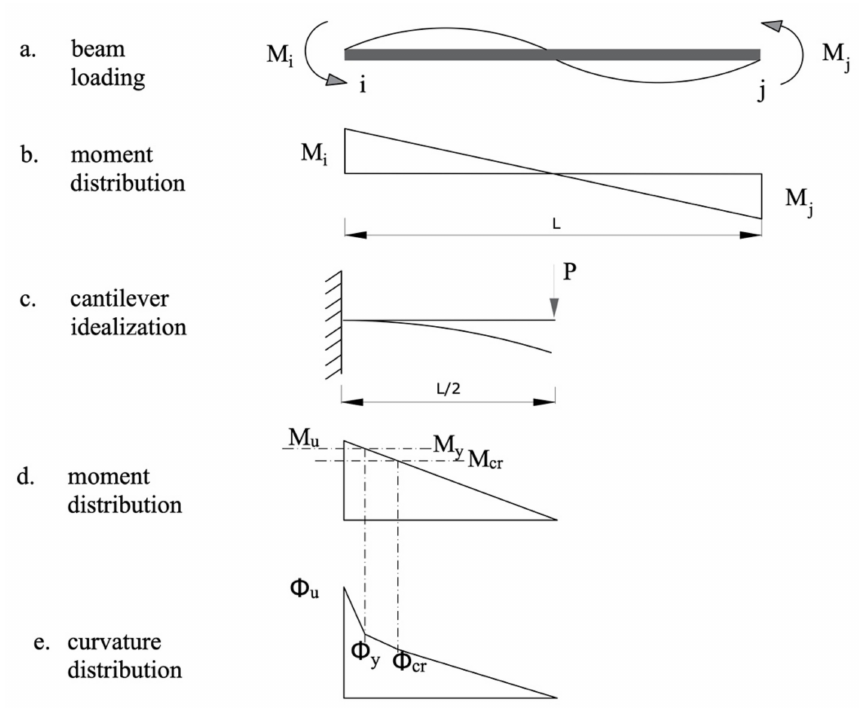
Figure 12. Mechanical parameters of fixed-end rotation beam–column member, considering only the rigid-body rotation mode of the